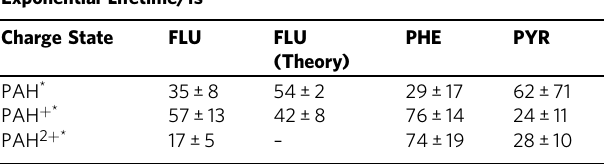
Table 1 Electronic decay lifetimes.